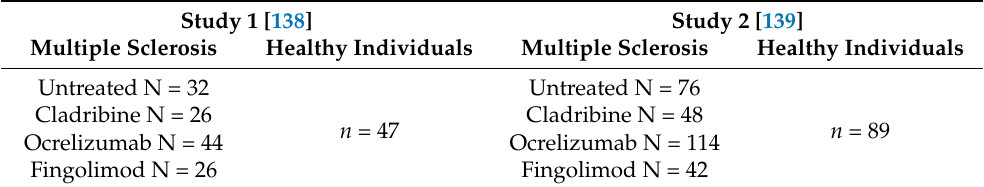
Table 7. Number of vaccinated cases among multiple sclerosis